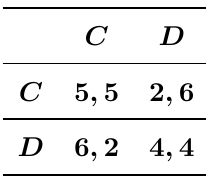
Table 8. A prisoner’s dilemma